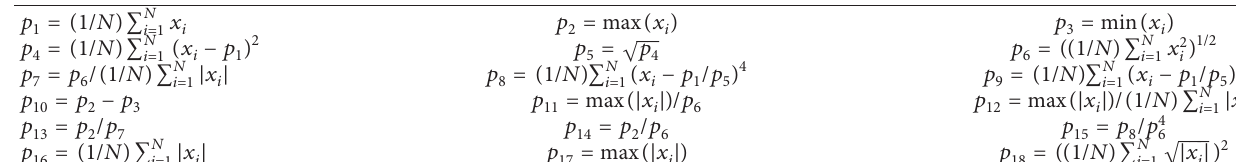
Table 1: Time-domain features.